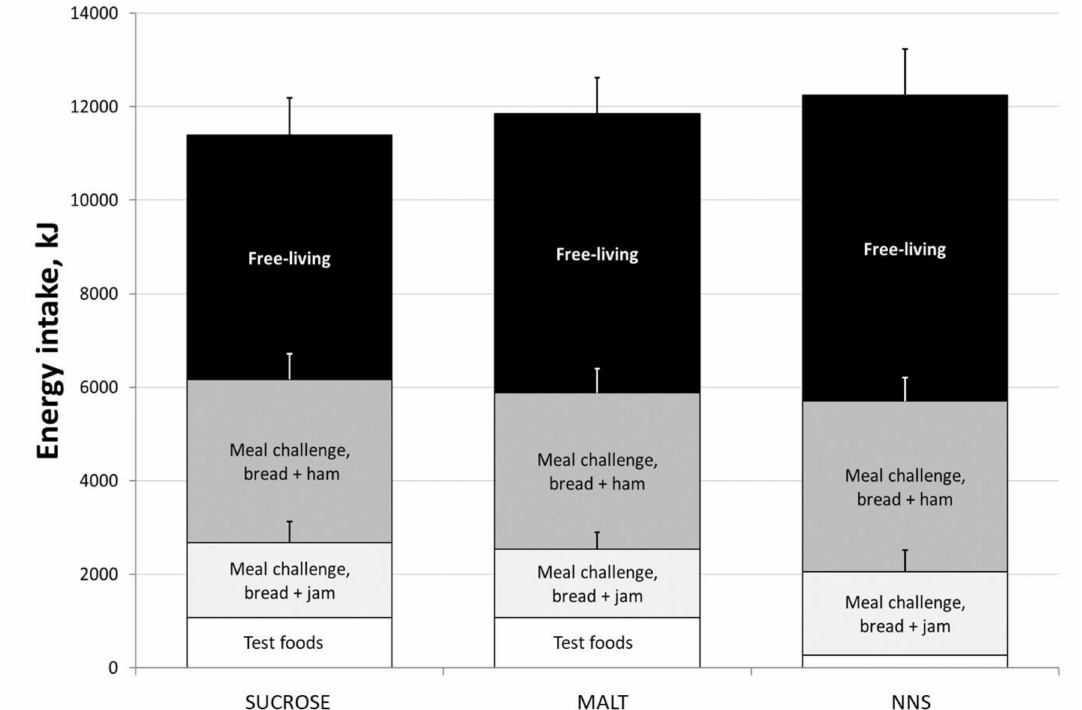
Figure 3. Total daily energy intake of participants from test foods, meal challenge, in a free-living environment on three test days. Bars represents total daily energy intake of study participants ( n = 11) after each test food. Each bar is further divided into energy intake from the study test food, intake during meal challenge (bread with jam or ham toppings), and intake on the remaining day. Error bars represent standard error of measurement. Total daily, meal challenge (bread + ham and bread + jam), and free-living energy intake were not significantly di ff erent among the three test